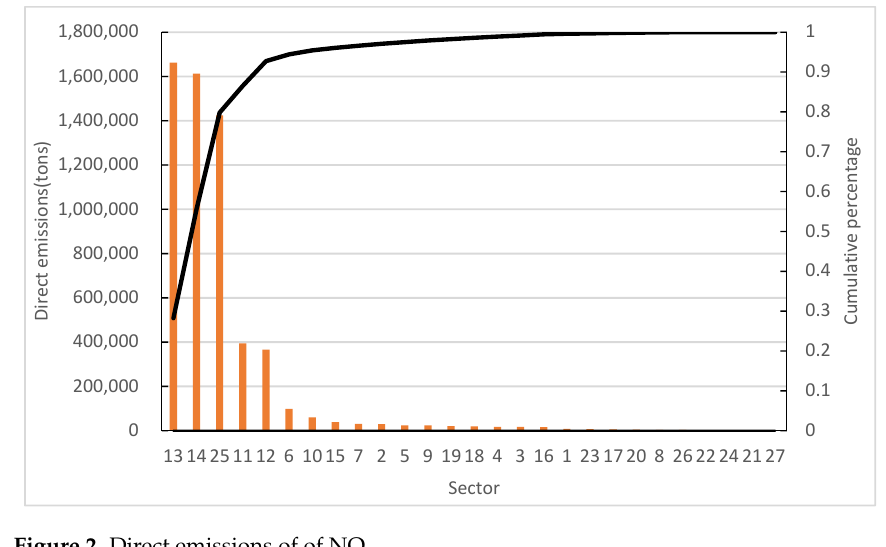
Figure 2. Direct emissions of of NO x .